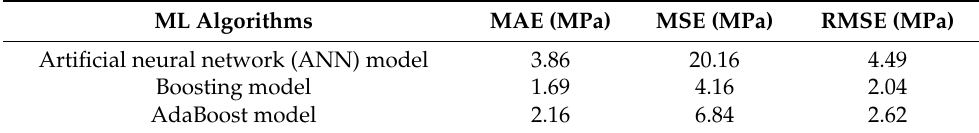
Table 3. Statistical checks for employed